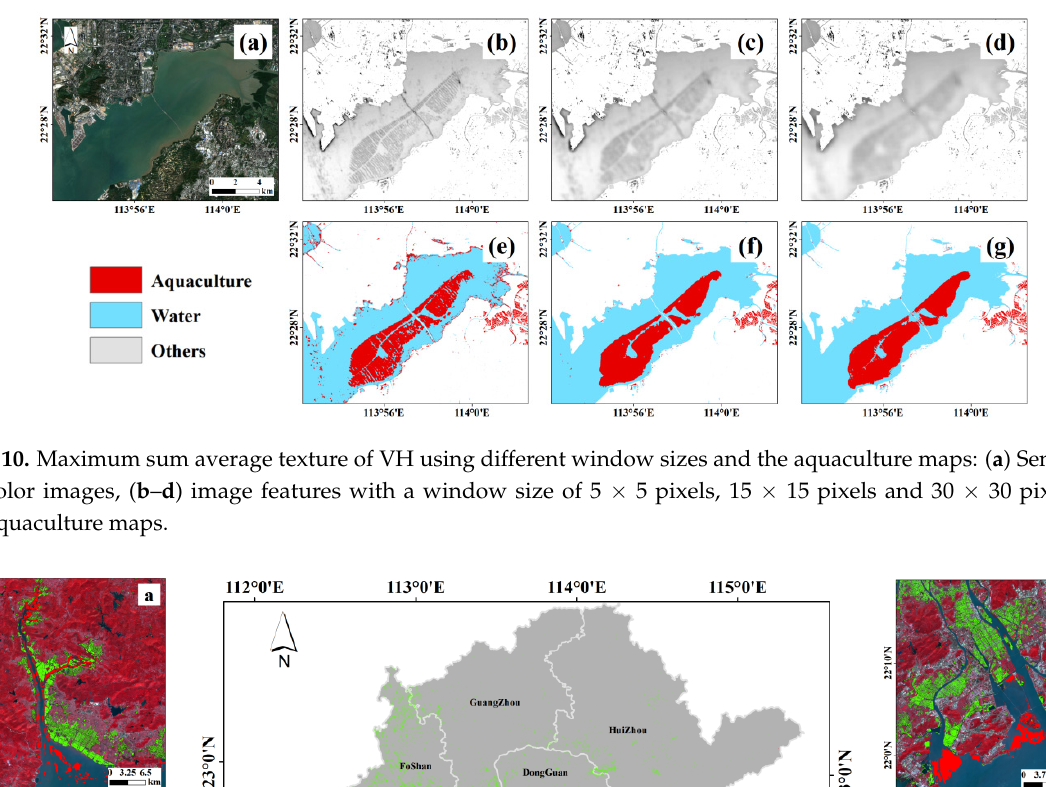
15 of 24 Figure 9. Typical classification maps using different thresholds: ( a ) Sentinel-2A MSI image, ( b ) T = − 0.2, ( c ) T = − 0.1, ( d ) T = 0, ( e ) T = 0.1, and ( f ) T = 0.2. 4.3. Optimal Window Size for Texture Calculation Figure 10 shows the maximum sum averaged texture derived from VH and the ex- tracted aquaculture with a window size of 5 × 5 pixels, 15 × 15 pixels, and 30 × 30 pixels,